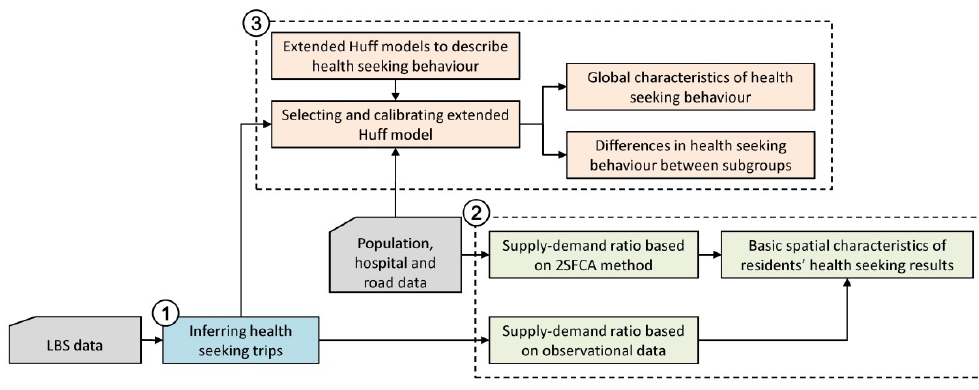
Figure 2. Research framework.